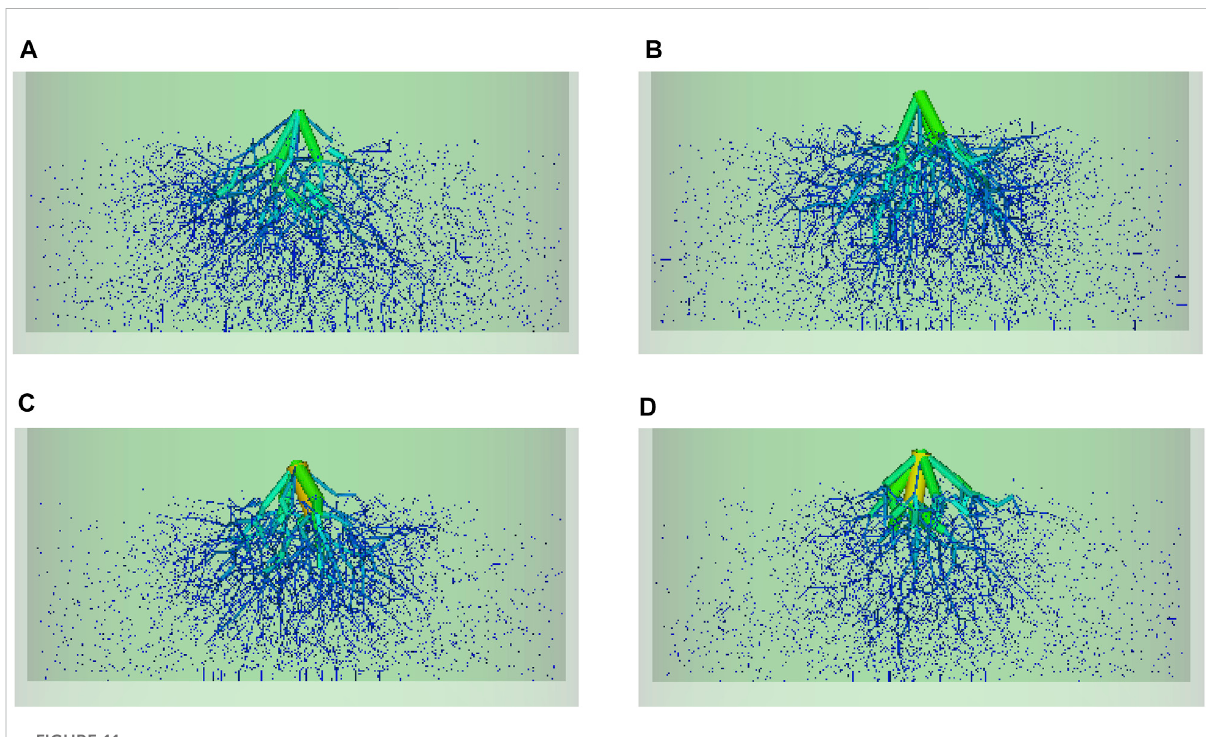
FIGURE 11 Comparative analysis of the evolution of normal force chains of different mixed particle materials at the same moment: (A) cylinder-cube; (B) sphere-cube; (C) sphere-cylinder; (D) sphere-cylinder-cube.